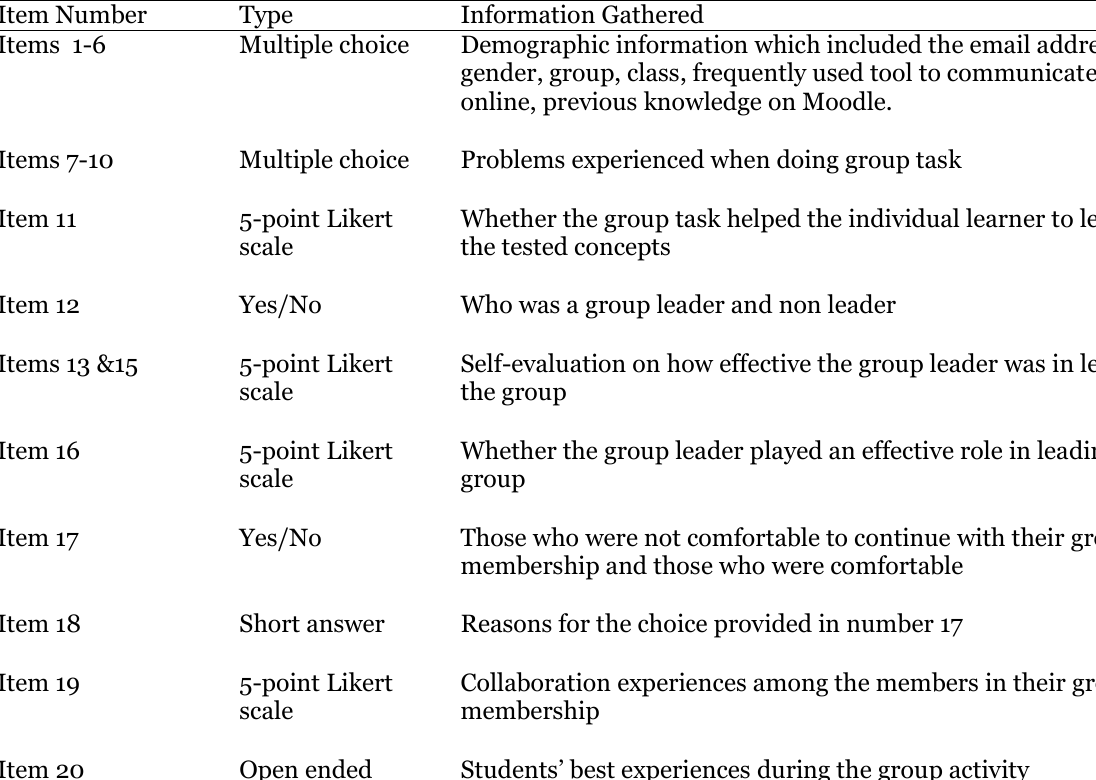
Description of Poststudy Questionnaire Items in Terms of Type and Information